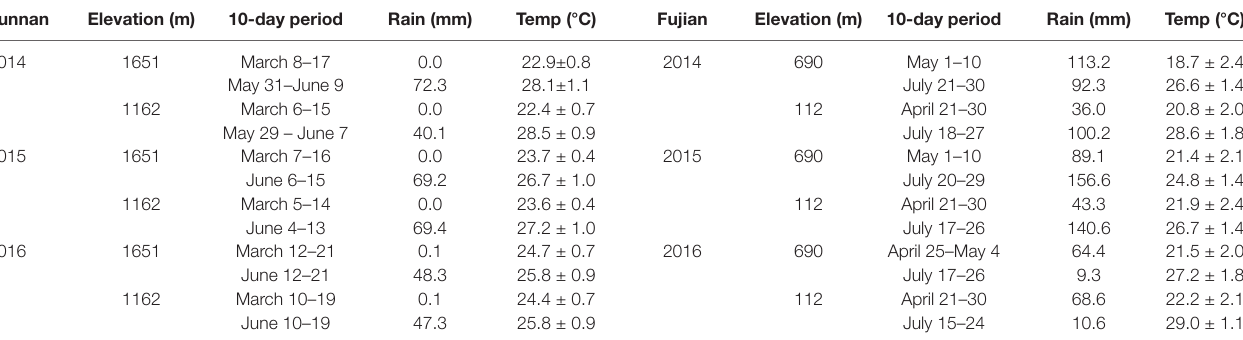
Rainfall data prior to March 12, 2014 was not available and could not be included in the analysis.